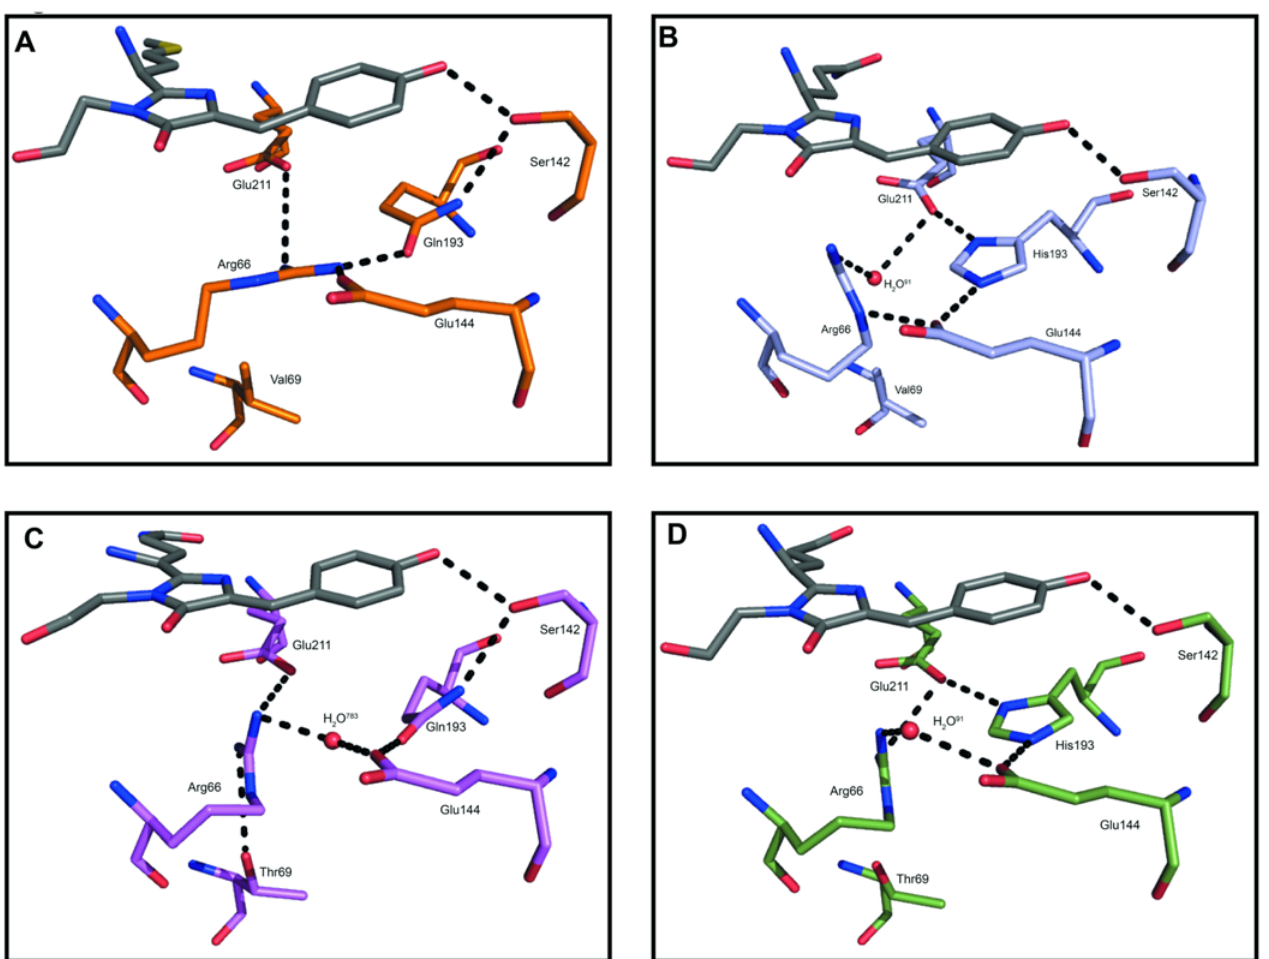
Fig 4. Alterations to the network of interactions that contribute to a scaffold around the chromophore of Phanta, eCGP123 T69V and eCGP123 H193Q and eCGP123. The network of interactions involving the chromophore and selected side chains differ between the non-fluorescent proteins (A) Phanta and (C) eCGP123 H193Q , and the highly fluorescent proteins (B) eCGP123 T69V and (D) eCGP123. Numbered waters are shown as red